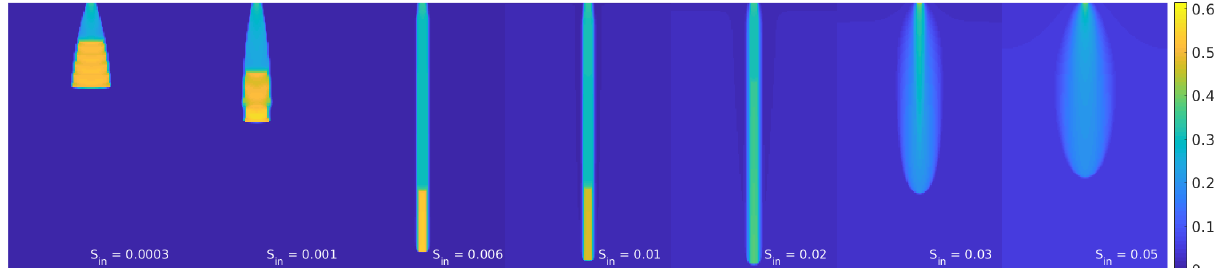
Figure A1. Snapshot of the saturation field at 25min for seven different values of the initial saturation. The distribution of the intrinsic permeability is not included. Saturation values are color coded according to the color bar on the right. Initial saturation of the medium increases from left to